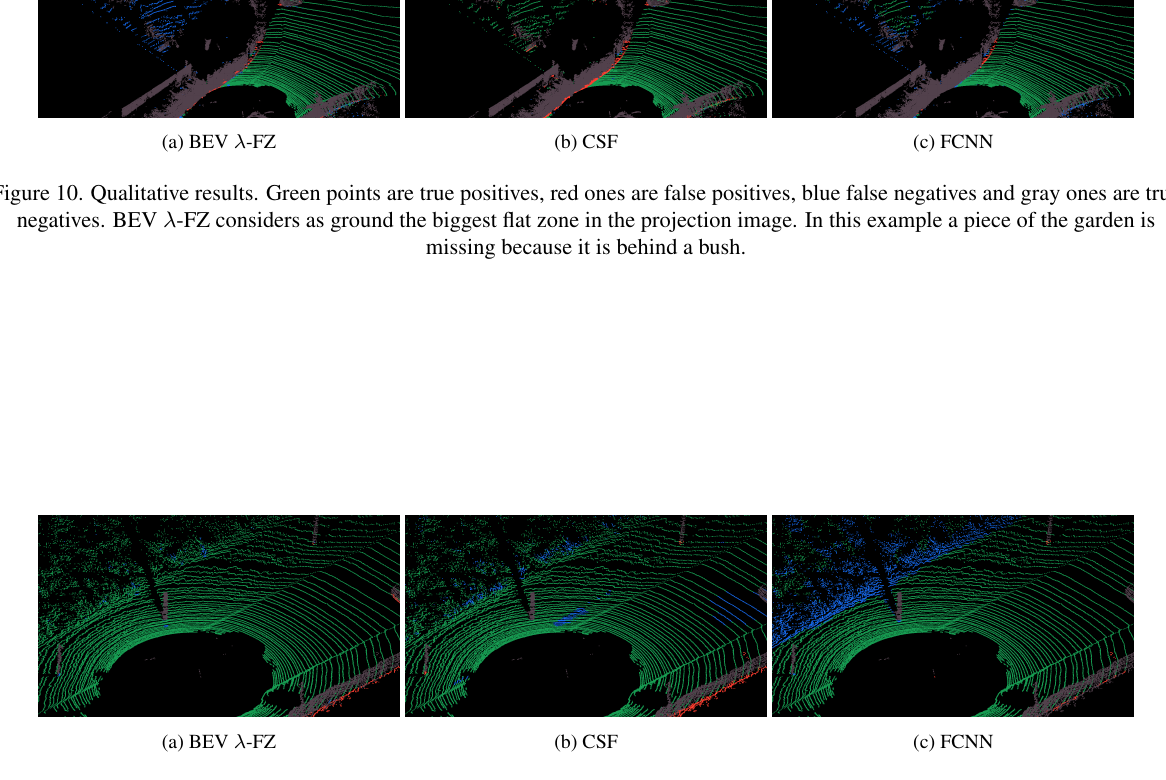
Figure 11. Qualitative results. Green points are true positives, red ones are false positives, blue false negatives and gray ones are true negatives. Predictions obtained by the three analysed methods. In this example FCNN fails to detect some terrain